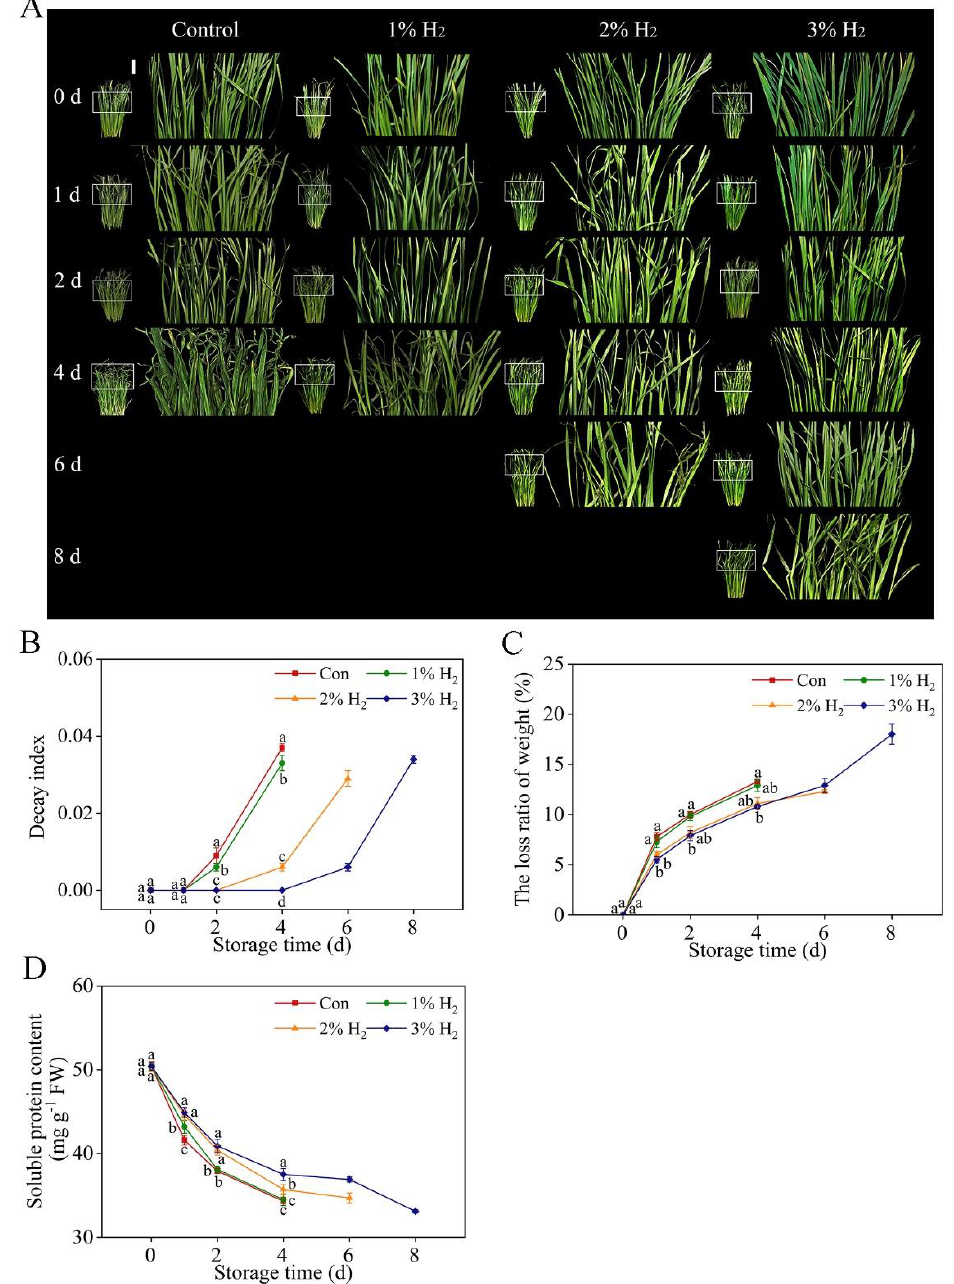
Figure 1. Effects of molecular hydrogen on shelf life of Chinese chive ( A ), decay index ( B ), the loss ratio of weight ( C ), and soluble protein content ( D ). Chinese chive was kept in air (control), 1% H 2 , 2% H 2 , and 3% H 2 during storage at 4 ± 1 °C. Error bars represent the standard error (SE; n = 15 for decay index, n = 15 for the loss ratio of weight, n = 5 for soluble protein content). Bars with different letters for each storage time are significantly different ( p < 0.05) according to Duncan’s multiple tests. Scale bar = 1 cm.